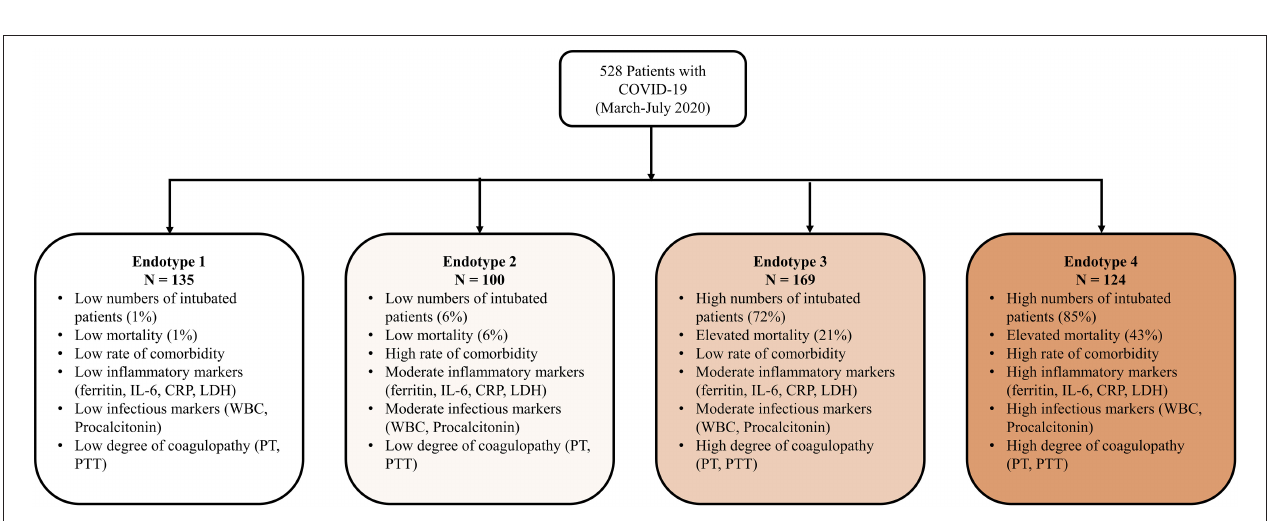
FIGURE 2 | Cumulative survival and discharge out of hospital by endotype. For each endotype, the cumulative survival and cumulative discharge of surviving patients from hospital is displayed in days from admission.